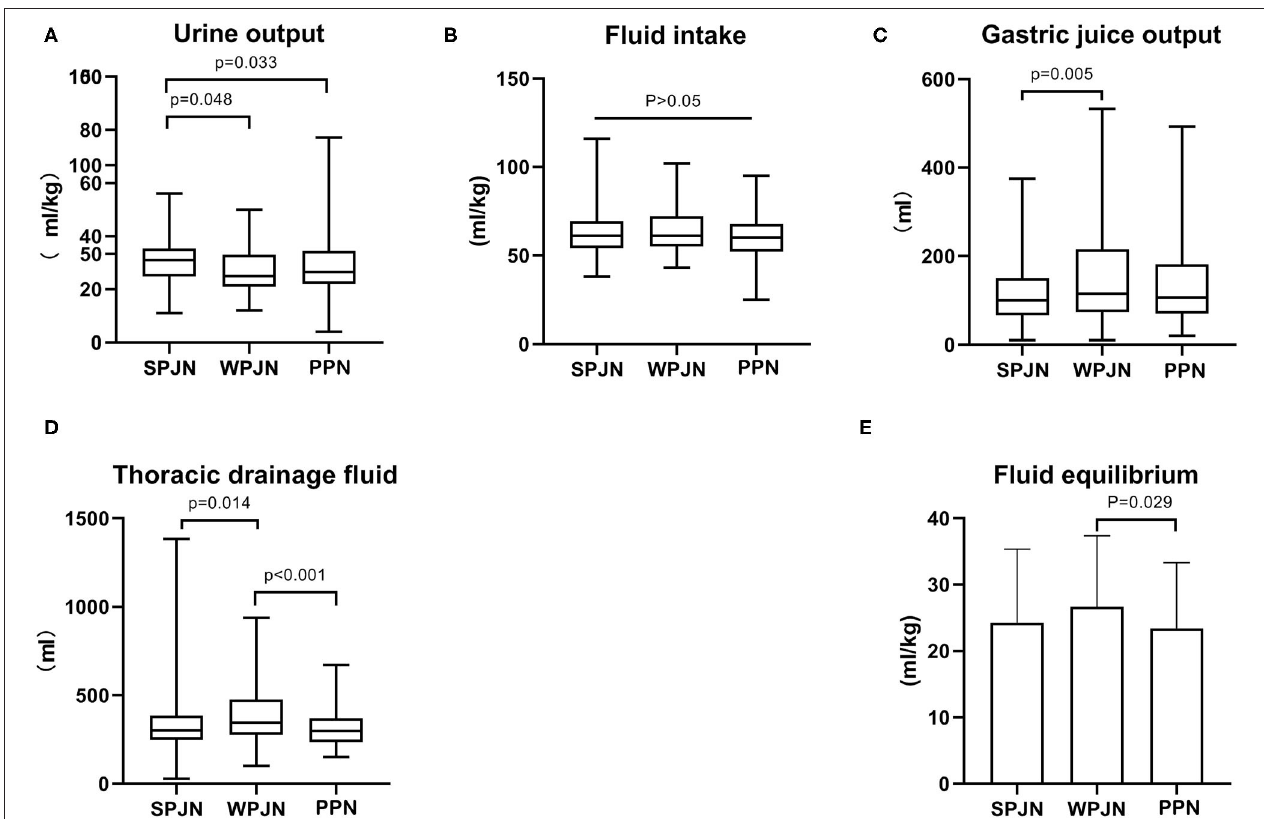
FIGURE 4 | Fluid intake and output. The differences in the fluid intake among the three groups were not statistically significant (A) . Patients in the SPJN group had a notably larger urine output compared to patients in the WPJN group and patients in the PPN group (B) . Furthermore, gastrointestinal decompression drainage fluid (gastric juice output) and thoracic drainage fluid in the SPJN group were significantly lower than those in the WPJN group (C,D) . In addition, thoracic drainage fluid and liquid equilibrium [total fluid intake—(urine output + gastric juice output + thoracic drainage fluid)] in the PPN group were prominently lower than those in the WPJN group (D,E) .